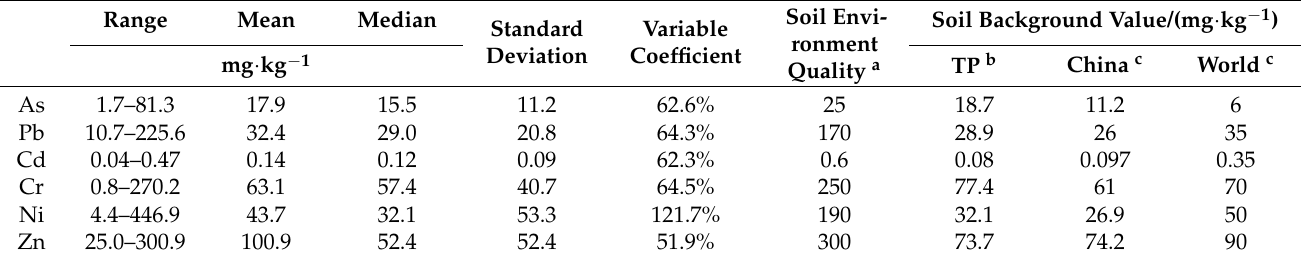
Table 2. Descriptive statistics analysis results for soil heavy